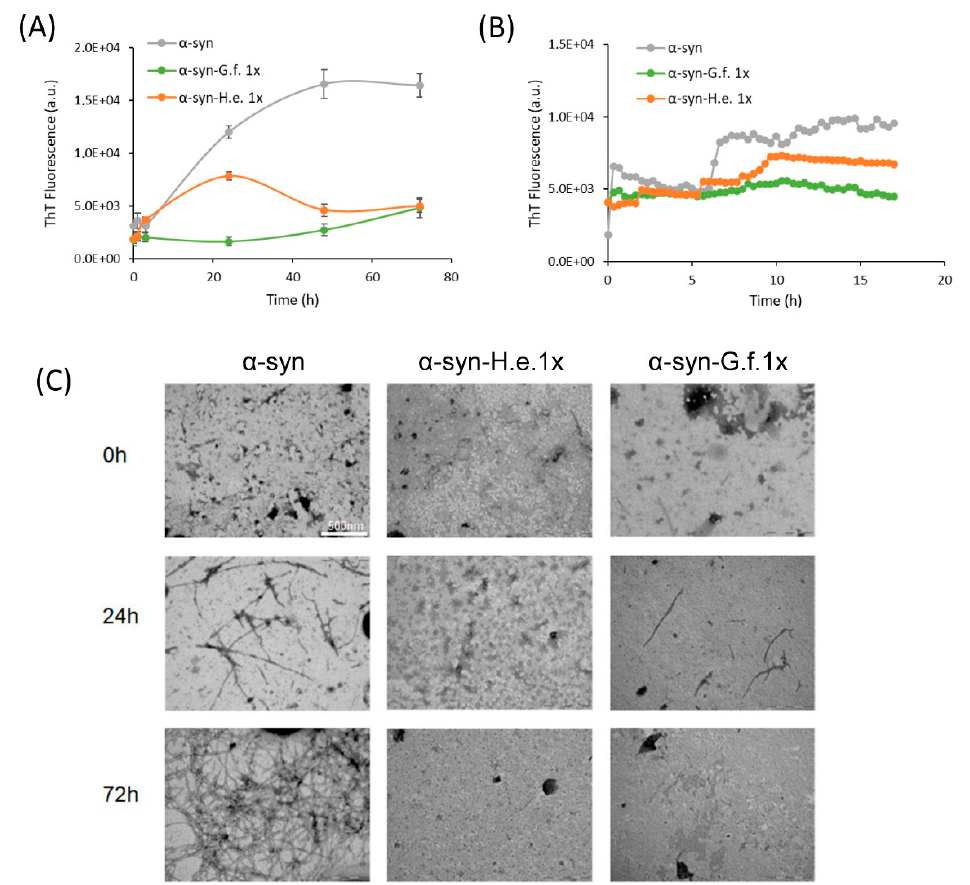
Figure 7. Fungal extract effects on α -syn aggregation process. ( A ) ThT fluorescence intensity of α -syn samples aggregated in the absence ( α -syn) or in the presence of G. frondosa ( a -syn-G.f.) or H. erinaceus (a-syn-H.e.) extract at α -syn:extract mass ratio 1:1 (1x) recorded at different times of aggregation (0 h, 24 h, 48 h and 72 h) or ( B ) in continuous for the first 15 h. ( C ) TEM images of α -syn aggregated for 0 h, 24 h or 72 h in the presence or in the absence of G. frondosa or H. erinaceus 1×.